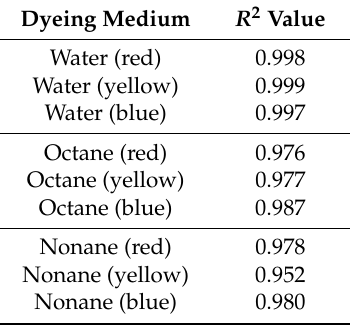
Figure 6. Calibration curves of dyed batch samples in water, octane, and nonane for color-matching. Table 6. R 2 values of dyeing in three primary colors based on dyeing method.